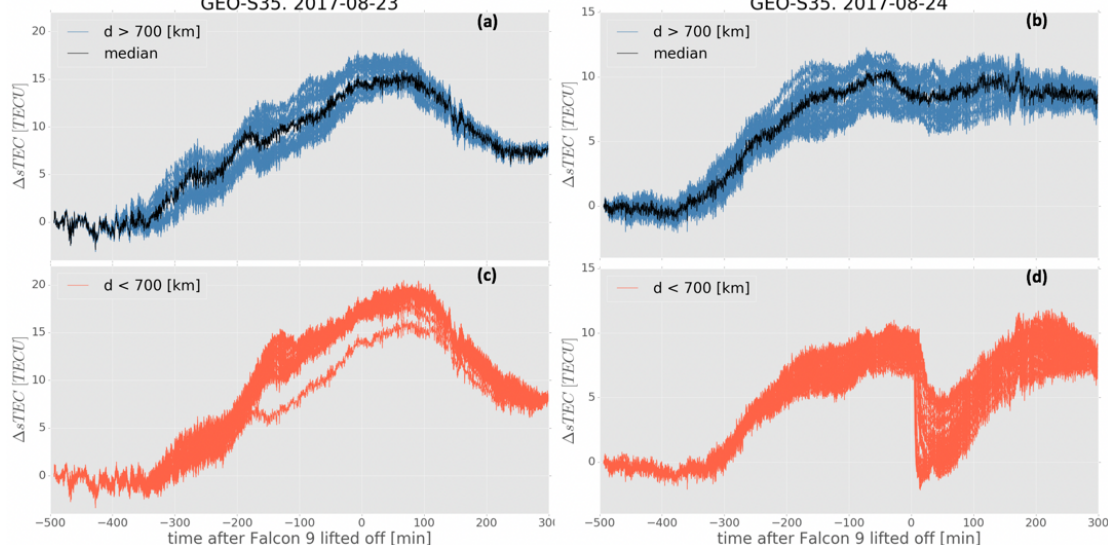
Figure 2. VARION-GEO δ sTEC results for satellite S35. Day before ( left column ) and day of the event ( right column ). The first row ( a , b ) represents the unfiltered VARION-GEO δ sTEC solutions far from the ionospheric hole (distance greater than 700 km). Time zero represents the time of the Falcon 9 launch (11:51 PDT). The second row ( c , d ) represents the unfiltered VARION-GEO δ sTEC solutions close to the ionospheric hole (distance smaller than 700